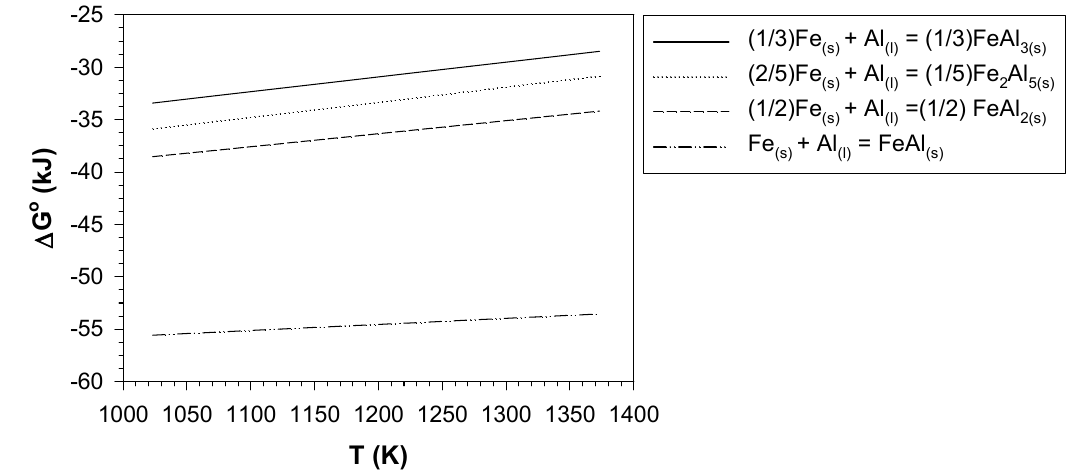
Figure 10. Gibbs free energies to form Fe–Al intermetallic compounds per one mole of Al at the standard state.